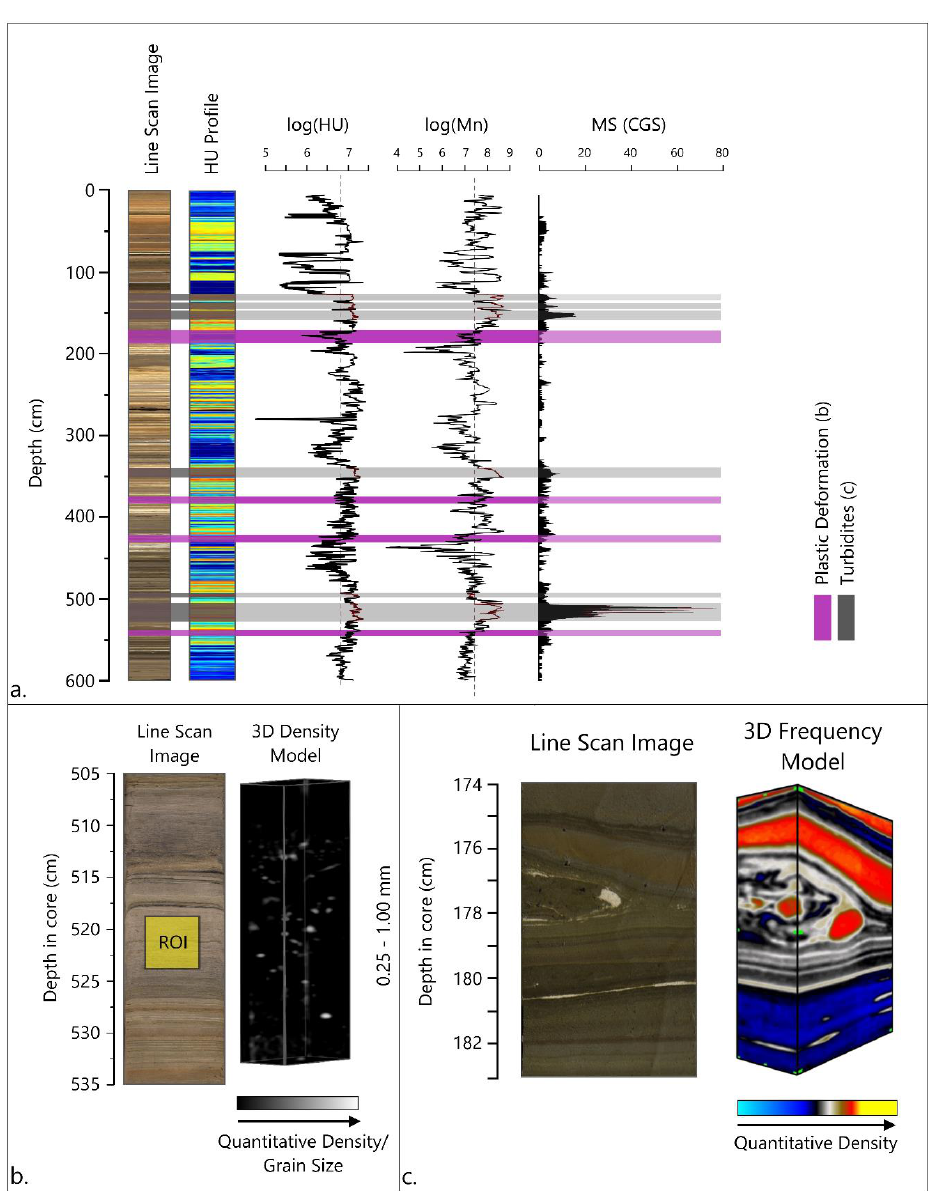
Figure 5. ( a ) Line scan image and HU colorized model of Vouliagmeni core, with log(HU), log (Mn) and magnetic susceptibility measurements profile. ( b ) Section of a non-varved sequence, with the compiled 3D grayscale model, presenting homogenous distribution of coarser sediment fractions. ( c ) Section of disturbed laminated sequence, with the 3D frequency model, showing laminae